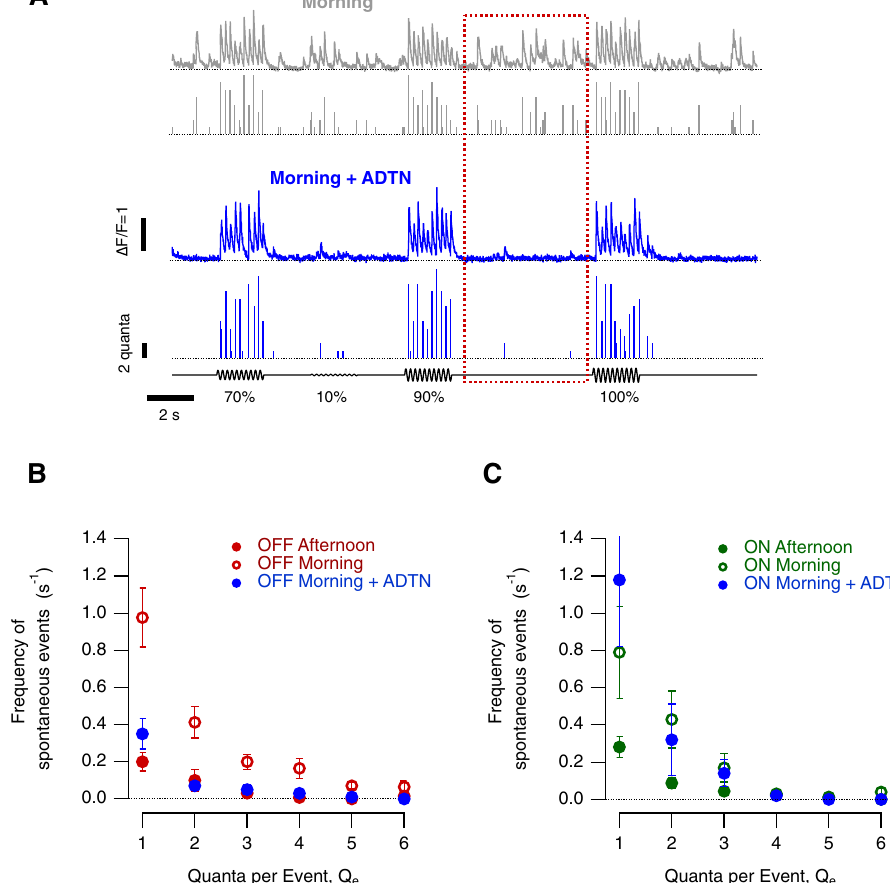
Fig. 4 Diurnal modulation of spontaneous synaptic noise. A Top: Example of iGluSnFR signals from an individual OFF synapse elicited using a stimulus of variable contrast in the morning (0 – 100%, 5 Hz modulation). In this example, note the high levels of spontaneous activity that were quanti fi ed as the responses elicited at zero contrast (red dashed box). Bottom . Examples of iGluSnFR signals from the same OFF synapse after intravitreal injection of ADTN. Note the increase in amplitude and frequency of events and the reduction of spontaneous activity. In each case the top trace shows the iGluSnFR signal and the lower trace the estimated Q e . B Quanti fi cation of spontaneous events composed by different Q e in OFF synapses in the morning, morning + ADTN and afternoon (OFF morning, n = 20 synapses; OFF morning + ADTN n = 12 synapses; OFF afternoon, n = 24 synapses). Note the suppression of spontaneous events in OFF synapses after intravitreal injection of ADTN in the morning. Each point shows the mean ± s.e.m. C Quanti fi cation of spontaneous events composed by different Q e in ON synapses in the Morning, Morning + ADTN and Afternoon (ON Morning n = 12 synapses; ON Morning + ADTN n = 5 synapses; ON Afternoon, n = 17 synapses). Note that spontaneous activity levels were not dramatically altered after administration of ADTN. Each point shows the mean ± s.e.m. Source data are provided as a Source Data fi